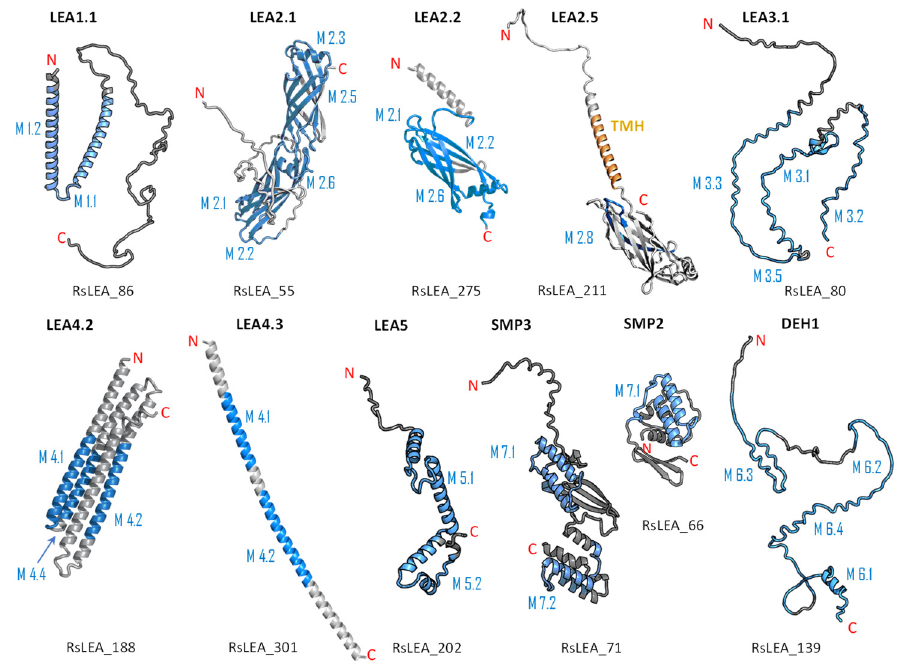
Figure 5. Three-dimensional models of the representative LEAPs of each R. serbica LEA protein family group. Detected MEME motifs are denoted in blue. The RsLEA code for each protein is given. Orange: transmembrane α -helix, TMH.